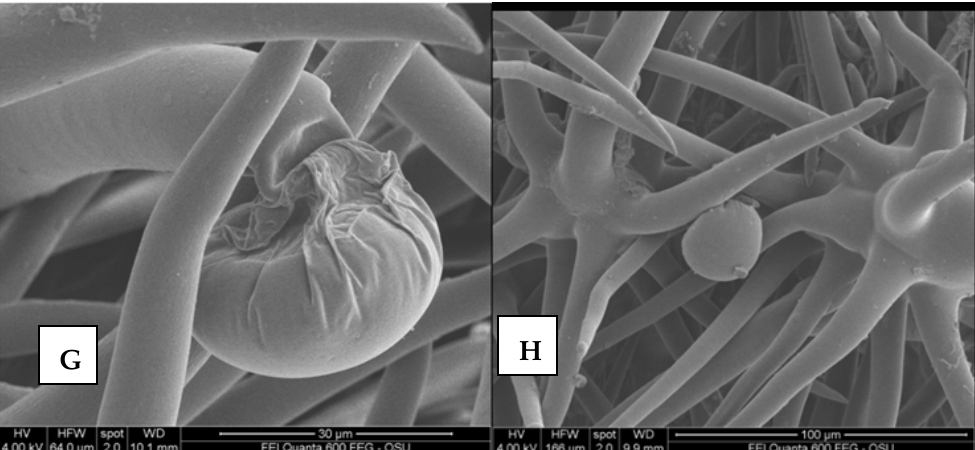
Figure 5. The leaves and calyx surfaces revealed after scanning electron microscopy (SEM) observations; ( A ) calyx inner surface with non-glandular trichomes; ( B ) calyx outer surface with non-glandular trichomes; ( C ) leaves surfaces with non-glandular and glandular trichomes; ( D ) close up of calix outer surfaces with non-glandular and glandular trichomes; ( E ) surfaces of non-glandular trichomes; ( F ) glandular peltate trichome, calyx; ( G ) glandular capitate trichome with some non-glandular trichomes; ( H ) leaves surfaces with non-glandular and glandular capitate trichomes.